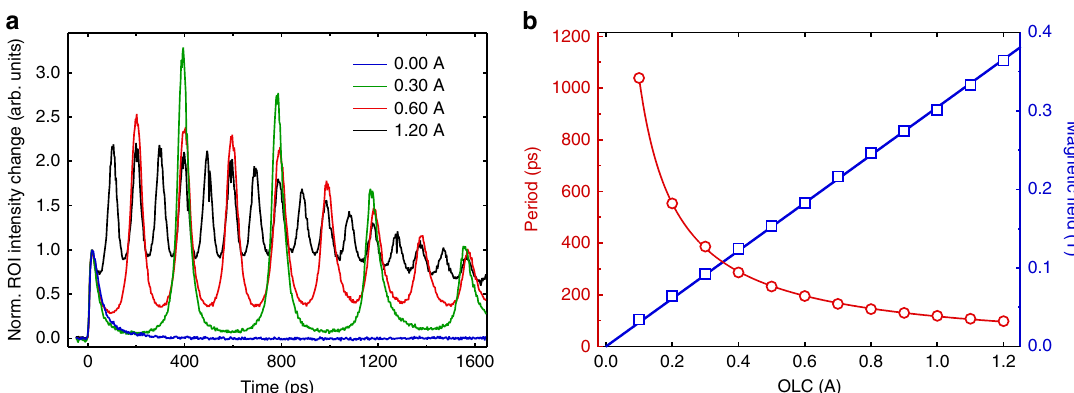
Fig. 4 Dependence on the objective lens current. a ROI difference intensity traces as a function of objective lens current (OLC). The traces have been normalized to the height of the fi rst peak ~12 ps after photoexcitation. The intermediate lens current was set to 1.1 A. Note that there are no oscillations for an OLC = 0 A. b Cyclotron oscillation period (red, left axis) as a function of the OLC. Using the cyclotron period formula T = 2 π m e /eB , the corresponding magnetic fi eld at the sample position is calculated (blue, right axis). The latter corresponds well with data from the manufacturer (see SI S1). The solid blue line is a linear fi t to